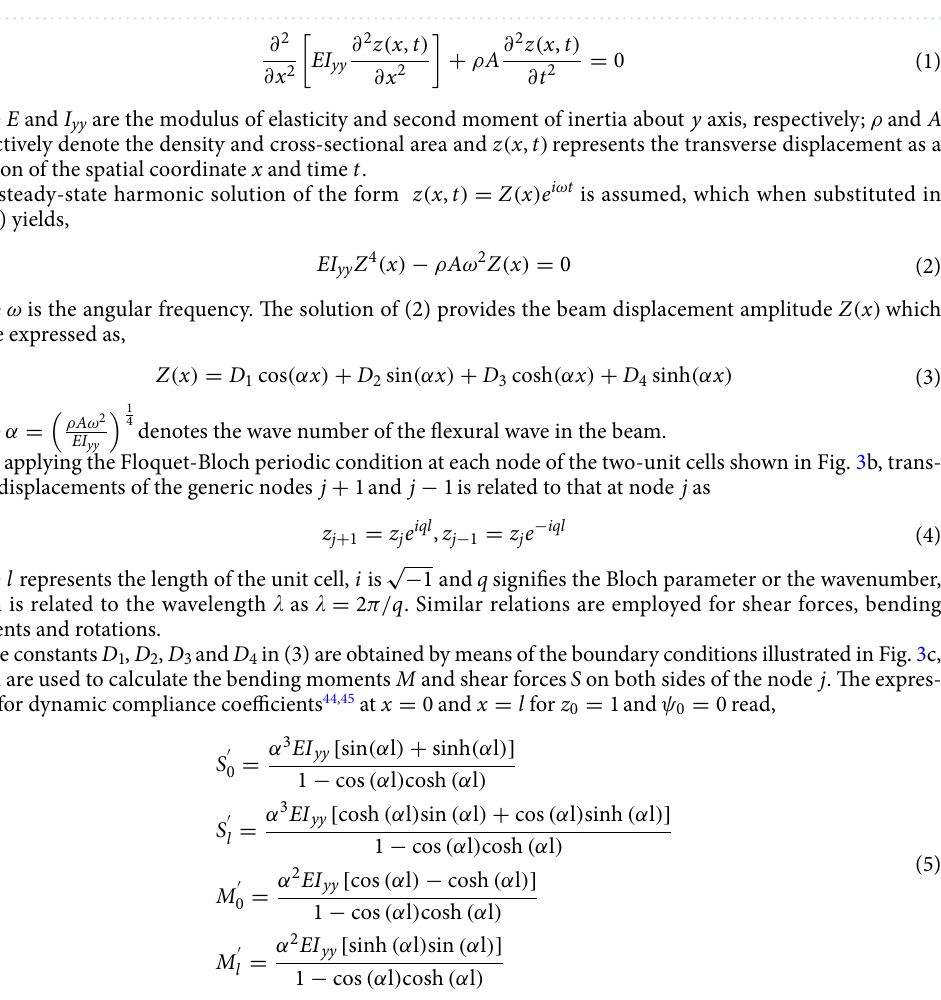
Figure 3. Theoretical modelling of a track structure in the lateral direction. ( a ) Two-unit cells; ( b ) periodic Floquet-Bloch condition imposed to the nodes for angular and transverse displacements; ( c ) single unit cell represented as a simple beam with rotation ψ 0 and transverse displacement z 0 at free end and clamped at the other end; and ( d ) equilibrium of forces and moments at node j